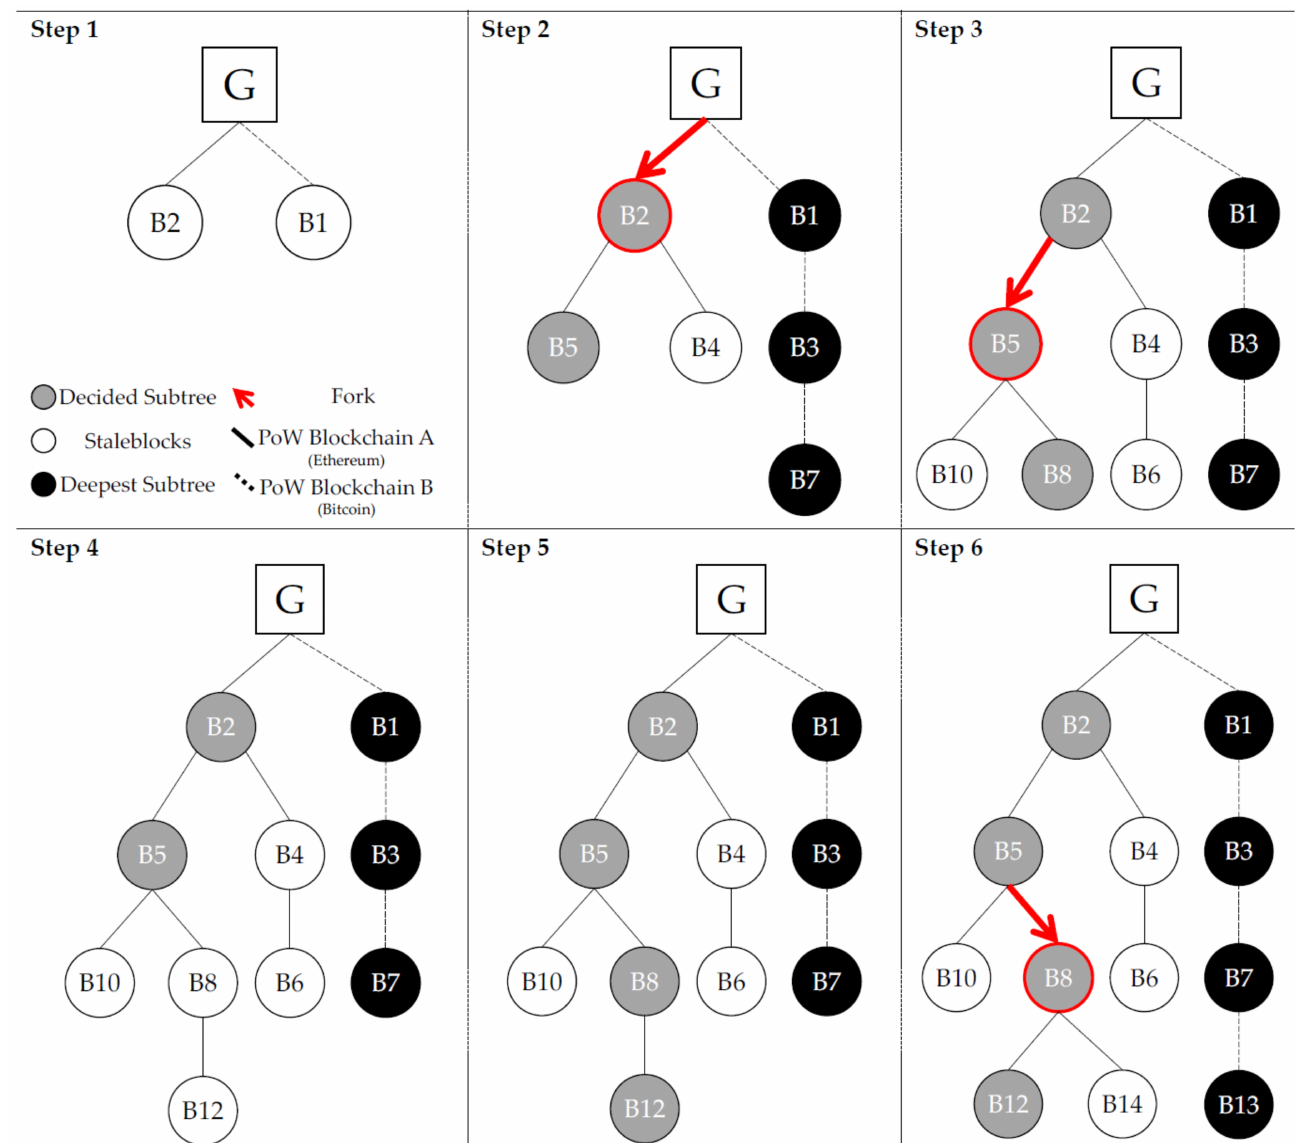
Figure 8. Subtree Deciding Process between Two Different PoW Blockchains (e.g., Bitcoin and